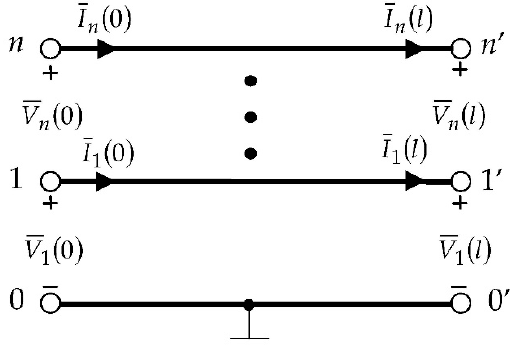
Figure 1. An ( n + 1)-conductor transmission line.